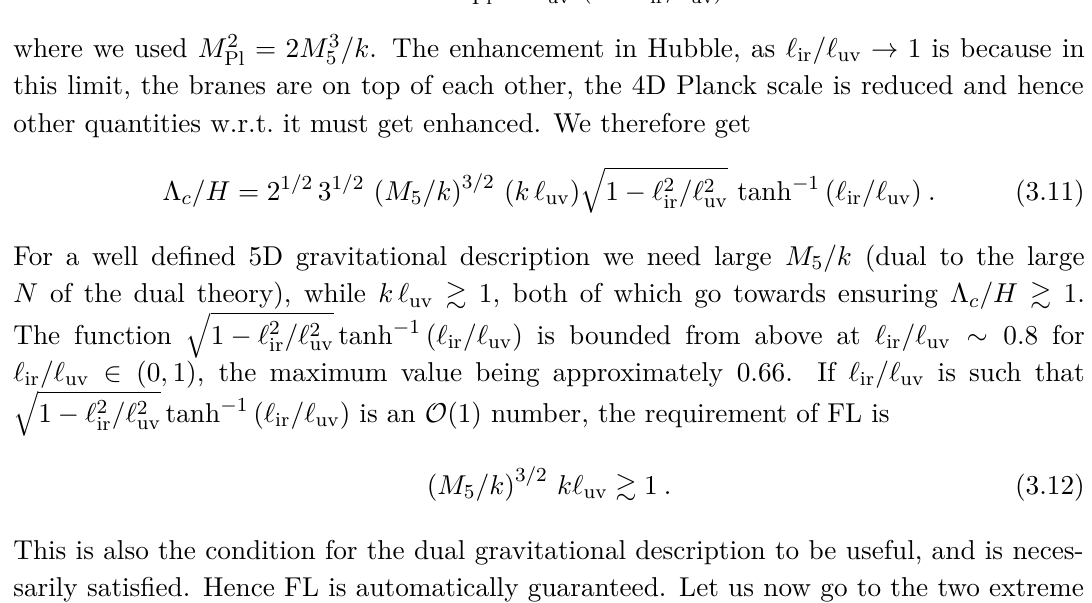
Figure 1 . Potential for X for ‘ uv = 10 , ‘ ir = 9 . 9 , with 12 M 3 dS extremum at X ∼ 2 . 5